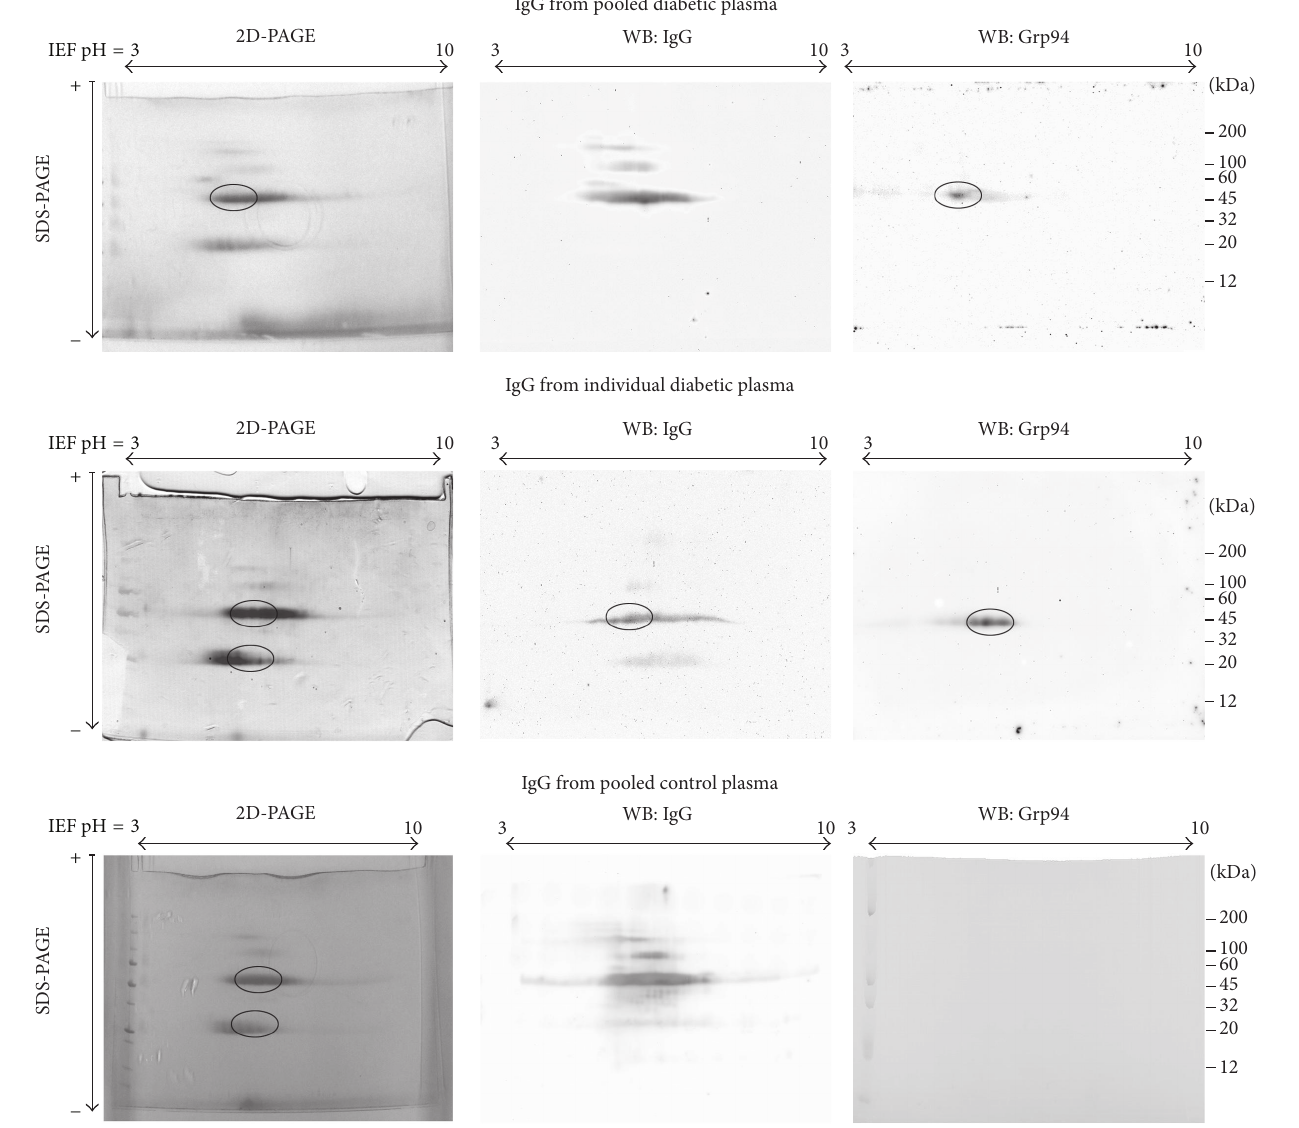
Figure2:Grp94islinkedtotheIgGheavychain.Panelsshow2DSDS-PAGEoftheIgGfractionpurifiedfromplasmaofbothdiabetic(pooled and single plasma) (upper and central panels, resp.) and healthy control subjects (pooled plasma, lower panels). Protein concentration was measured with the BCA protein assay and 41.5 𝜇 g proteins of each sample were loaded in the gel. Correctness of the protein loading was assessed by prior explorative SDS-PAGE. 2D SDS-PAGE of each sample was conducted in duplicate: one gel was used for mass analysis and the other blotted and probed with anti-Grp94 Abs and then with anti-IgG biotin-conjugated Abs followed by exposure to HRP-conjugated streptavidin. After stripping, the membrane was exposed to anti-human IgG primary Abs followed by incubation with HRP-conjugated secondary Abs. Horizontal and vertical arrows indicate, respectively, the range of pH (3–10) at which sample proteins focused in the first iso-focusing PAGE and the direction of the run (from the cathode to the anode) in the second dimension SDS-PAGE. Circled are parts of IgG bands, including those positive for Grp94, excised for mass